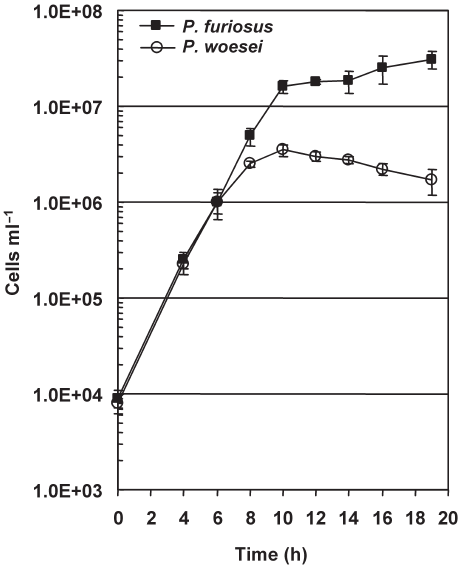
Figure 1. Growth of P. furiosus and P. woesei in sulfur-free medium containing 1% maltose and 100 µM sodium tungstate. Triplicate cul- tures of P. furiosus and P. woesei were incubated anaerobically at 95 °C. Cells were counted in at least 50 of the 50 × 50 µm squares.